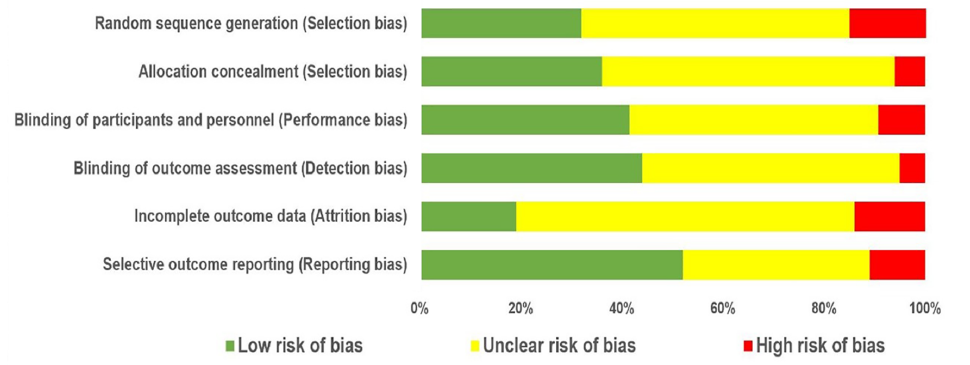
Figure 4. Assessment of the risk of bias in the 128 studies selected for this review by using the Cochrane Collaboration tool.